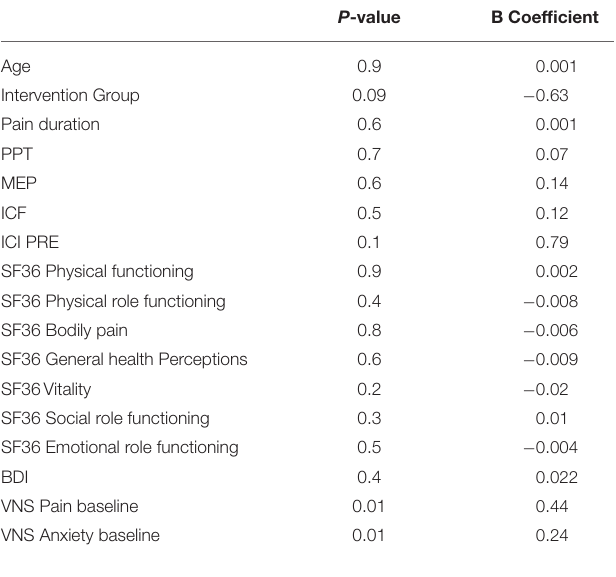
TABLE 4 | Results for univariate linear regression models.